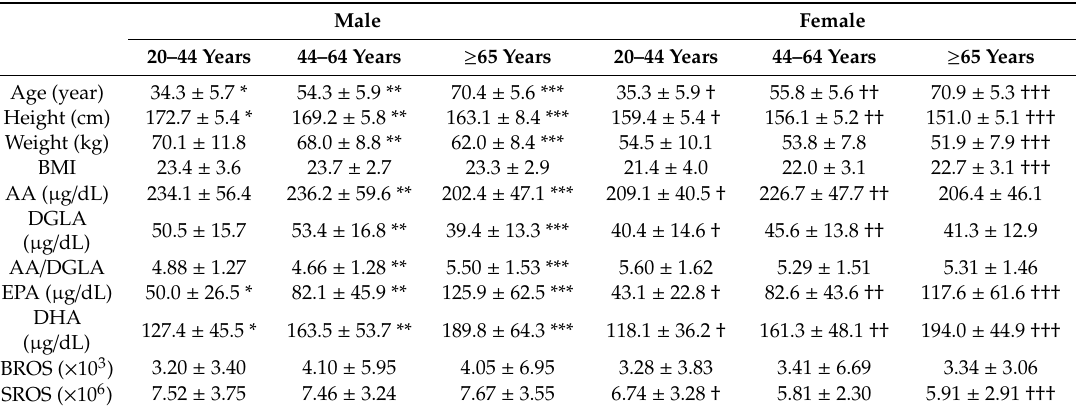
Table 1. Clinical characteristics of study